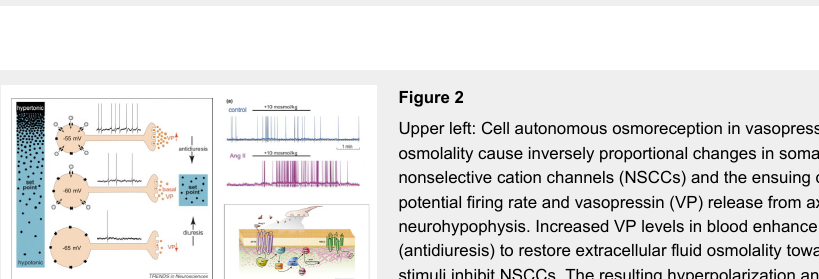
Schematic representation of the osmoregulatory pathway of the hypothalamus (sagittal section of midline of ventral brain around the 3rd ventricle in mice). Neurons (lightly filled circles) in the lamina terminalis (OVLT), median preoptic nucleus (MnPO) and subfornical organ (SFO) – that are responsive to plasma hyptertonicity send efferent axonal projections (grey lines) to magnocellular neurons of the paraventricular (PVN) and supraoptic nuclei (SON). The OVLT is one of the brain circumventricular organs and is a key osmosensing site in the mammalian brain (vide infra). The processes (dark lines) of these magnocellular neurons form the hypothalamo-neurohypophysial pathway that courses in the median eminence to reach the posterior pituitary, where neurosecretion of vasopressin and oxytocin occurs. (Modified from [80]).